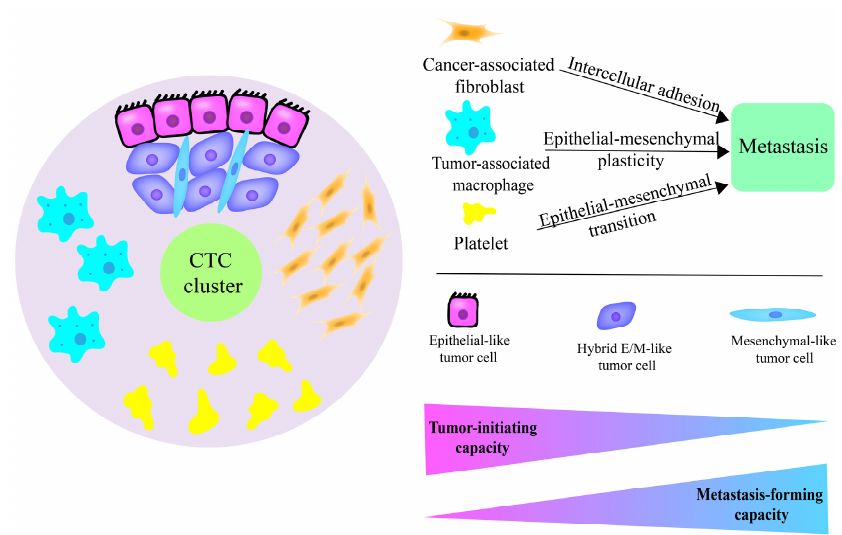
Figure 1. Cells that make up circulating tumor cell (CTC) clusters. CTC clusters include tumor cells and non-malignant cells that consist primarily of tumor-associated macrophages (TAMs), cancer- associated fibroblasts (CAFs), and platelets. Tumor cells undergo the epithelial–mesenchymal tran- sition (EMT), and they exhibit three phenotypes: epithelial phenotype, mesenchymal phenotype, and hybrid E/M phenotype. The epithelial phenotype has the capacity for tumor initiation, and the mesenchymal phenotype has the capacity to form metastasis. The hybrid E/M phenotype is equipped with both capacities. TAMs, CAFs, and platelets each play roles in metastasis and prostate cancer invasion. The hybrid EMT cell state, with both epithelial and mesenchymal features, is recon- cilable with the state of highly plastic stem-like cells. Similarly, in the process of blood dissemination, CTCs undergoing EMT possess features of CSC-like tumor cells that are responsible for generating most of the metastatic foci, as well as capabilities of resistance to radio- and chemotherapy-based treatment [11,63]. Likewise, CTC clusters have been observed expressing more mesenchymal transcripts in patients receiving cancer treatment [64]. A study suggested that 35/46 (76%) CTCs were CD133-positive, a putative prostate cancer stem cell marker, in 35 patients with high-risk, localized prostate cancer; the re- searchers demonstrated that the CD133 and E-cadherin-positive CTC fragments were as- sociated with biochemical recurrence at 1 year [65]. Compared to single CTCs in the DNA methylation landscape of 43 breast cancer patients and 3 mouse models, CTC clusters re- sulted in hypomethylation in the binding sites of OCT4, NANOG, SOX2, and SIN3A. However, single CTCs featured hypomethylation of other TFBSs, including those that are occupied by MEF2C, JUN, MIXL1, and SHOX2. [19]. Additionally, most of these binding sites were occupied by master stemness and associated with proliferation regulators. The patterns were similar to those of embryonic stem cells. Of note, NANOG is essential to the